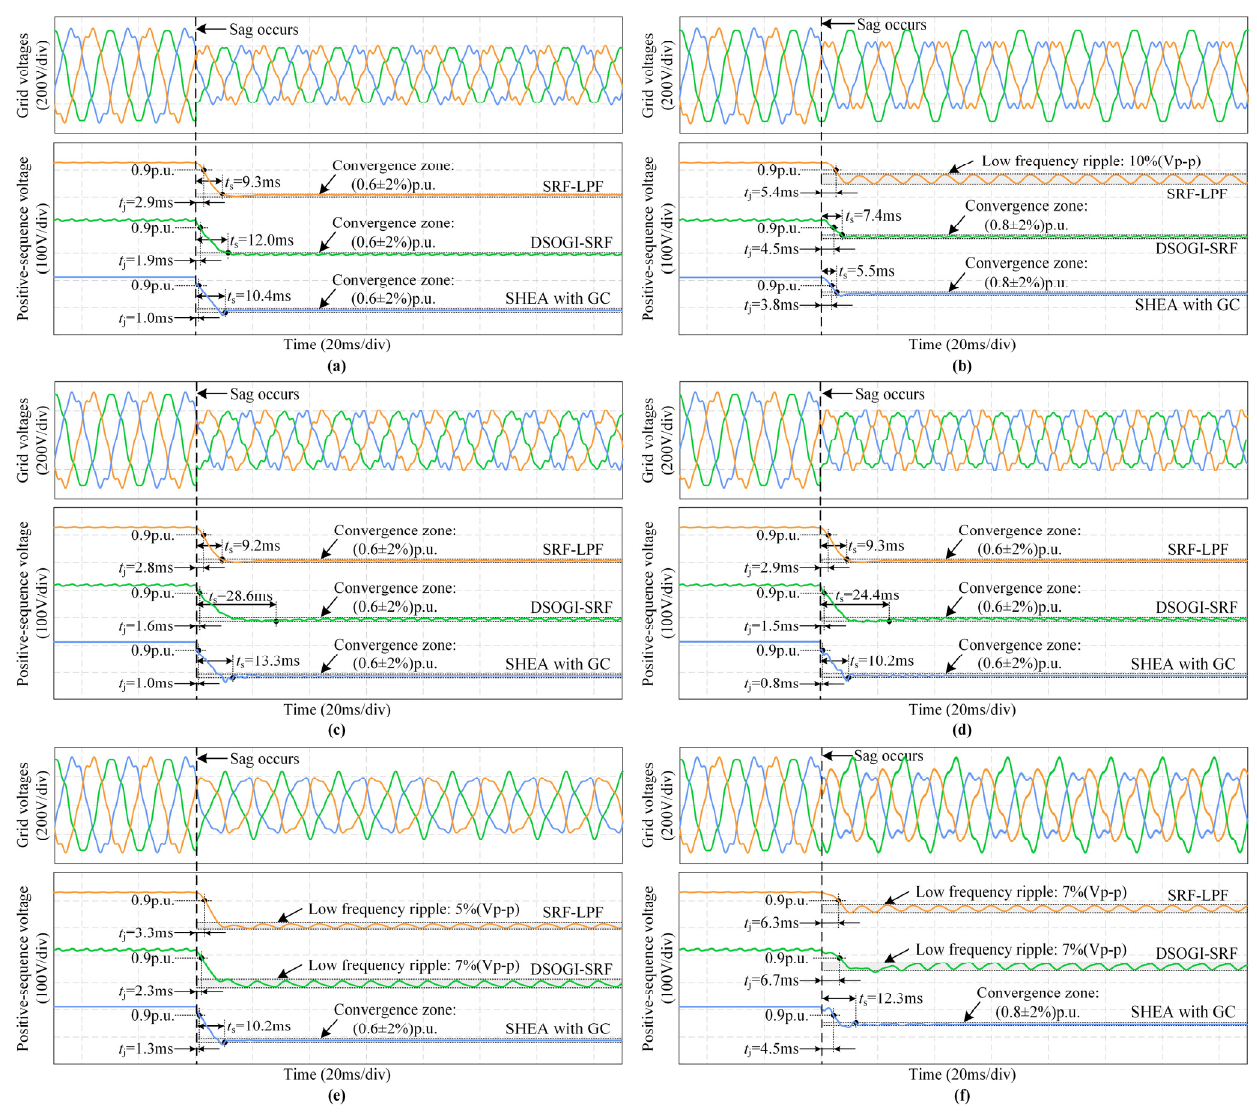
Figure 11. The results for different voltage detection methods (SRF-LPF, DSOGI-SRF, SHEA with GC) under different working conditions: ( a ) symmetrical sag; ( b ) asymmetrical sag; ( c ) symmetrical sag with phase variation; ( d ) symmetrical sag with frequency drift; ( e ) symmetrical sag with low- frequency harmonic interference and high-frequency noise; ( f ) asymmetrical sag with comprehensive disturbance.